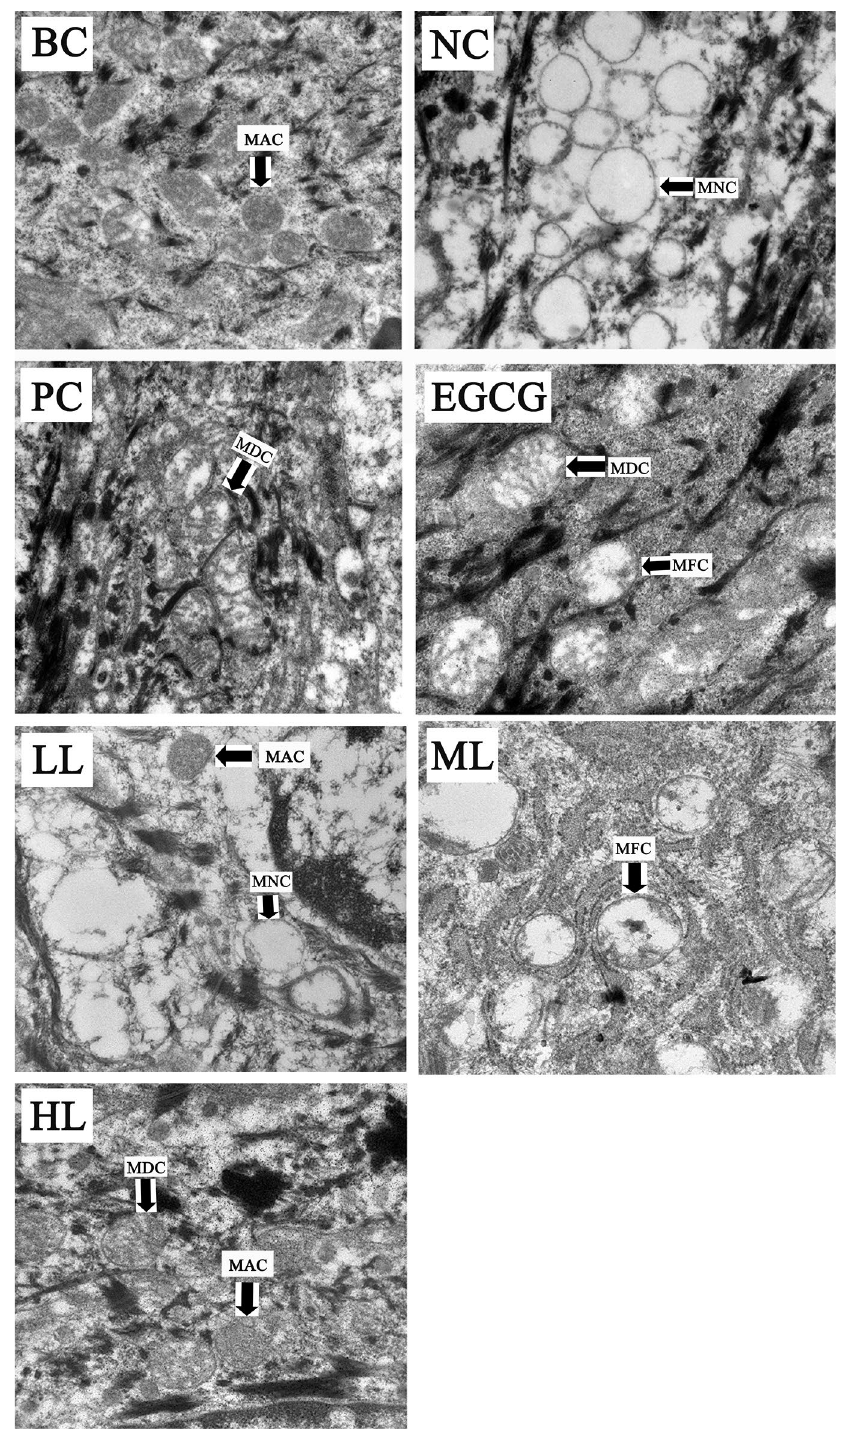
Figure 5. Effect of GCG on UVB-induced damage of mitochondria in skin of male hairless mice. BC blank control, NC negative control, PC positive control, EGCG EGCG treatment, LL low level GCG, ML medium level GCG, HL high level GCG, MAC mitochondrion with abundant cristae, MDC mitochondrion with decreased cristae, MFC mitochondrion with few cristae, MNC mitochondrion without